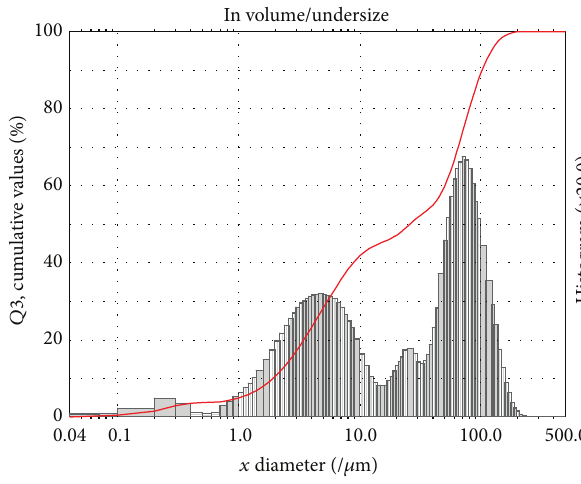
Figure 3: Particle size distribution of calcium oxide from mud clam shell.